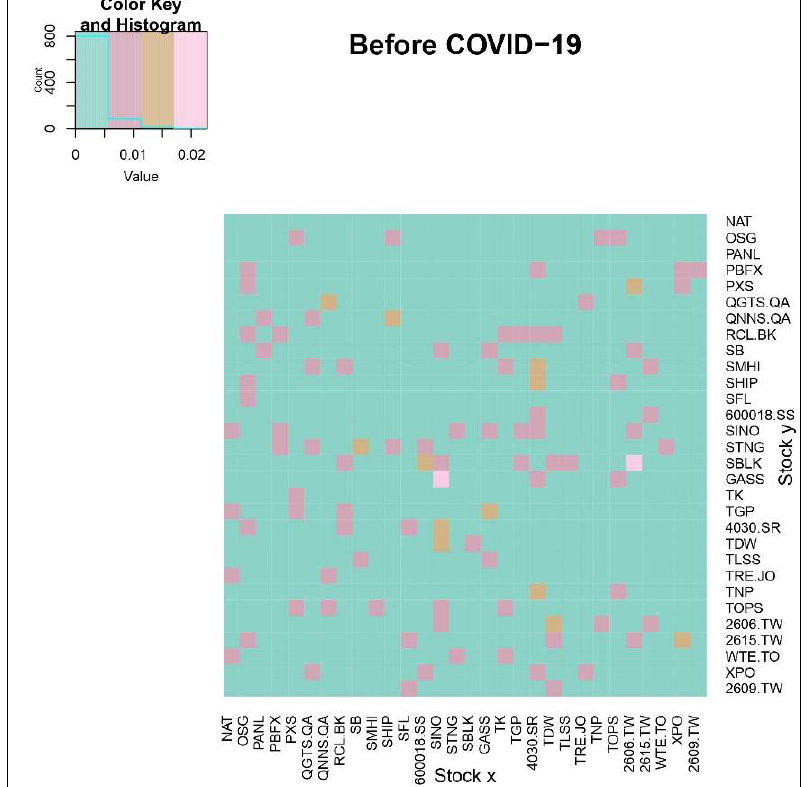
Figure 2. The information flow (effective transfer entropy) from stock y to stock x, for the companies 41 through 70 (listed in Table 1), before the COVID-19 outbreak